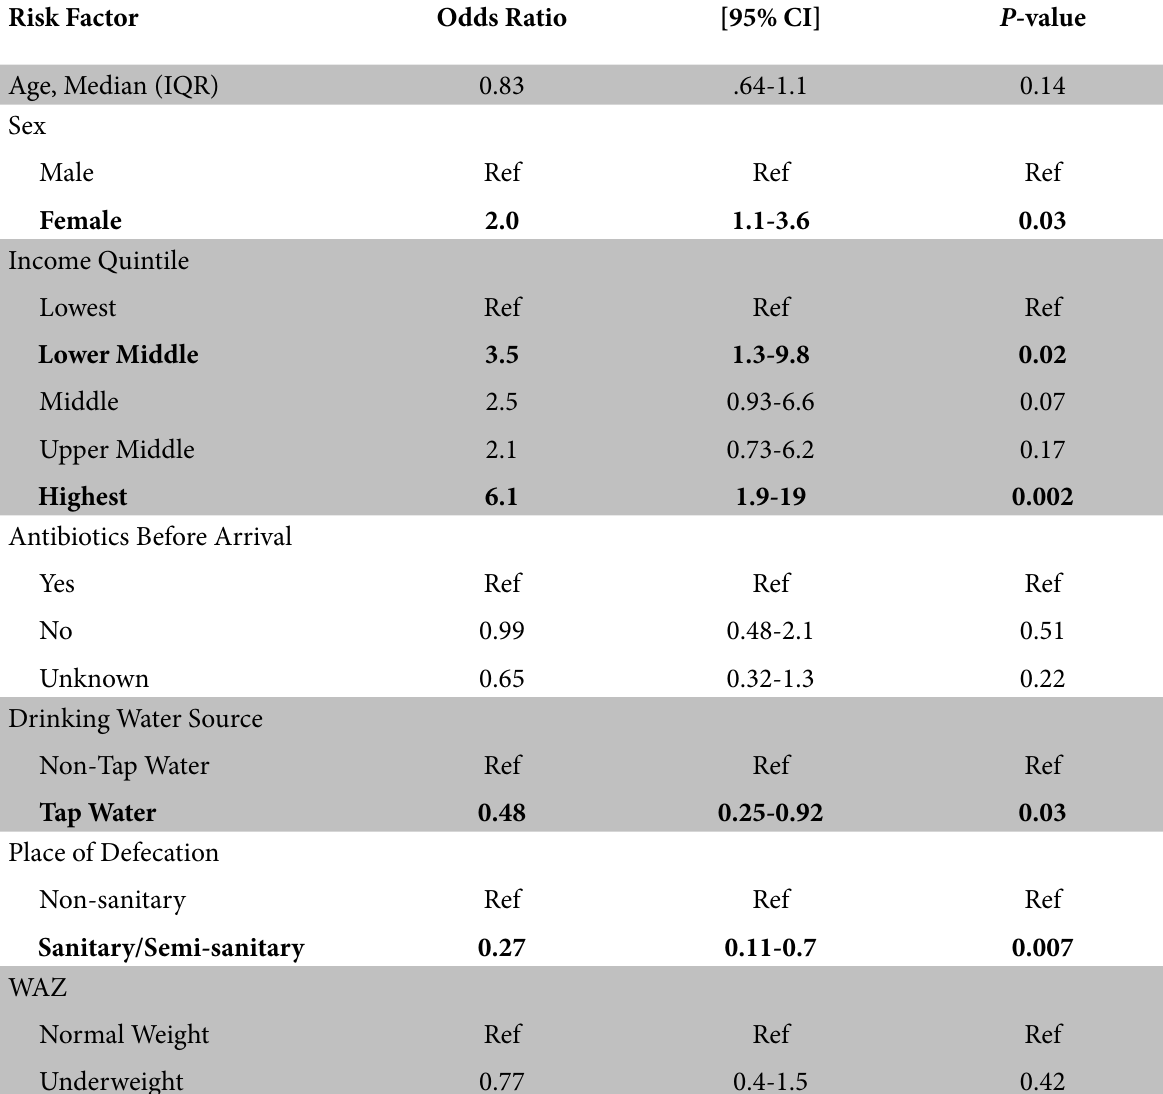
Table 4. Multivariate logistic regression. Probability modeled is Ciprofloxacin =